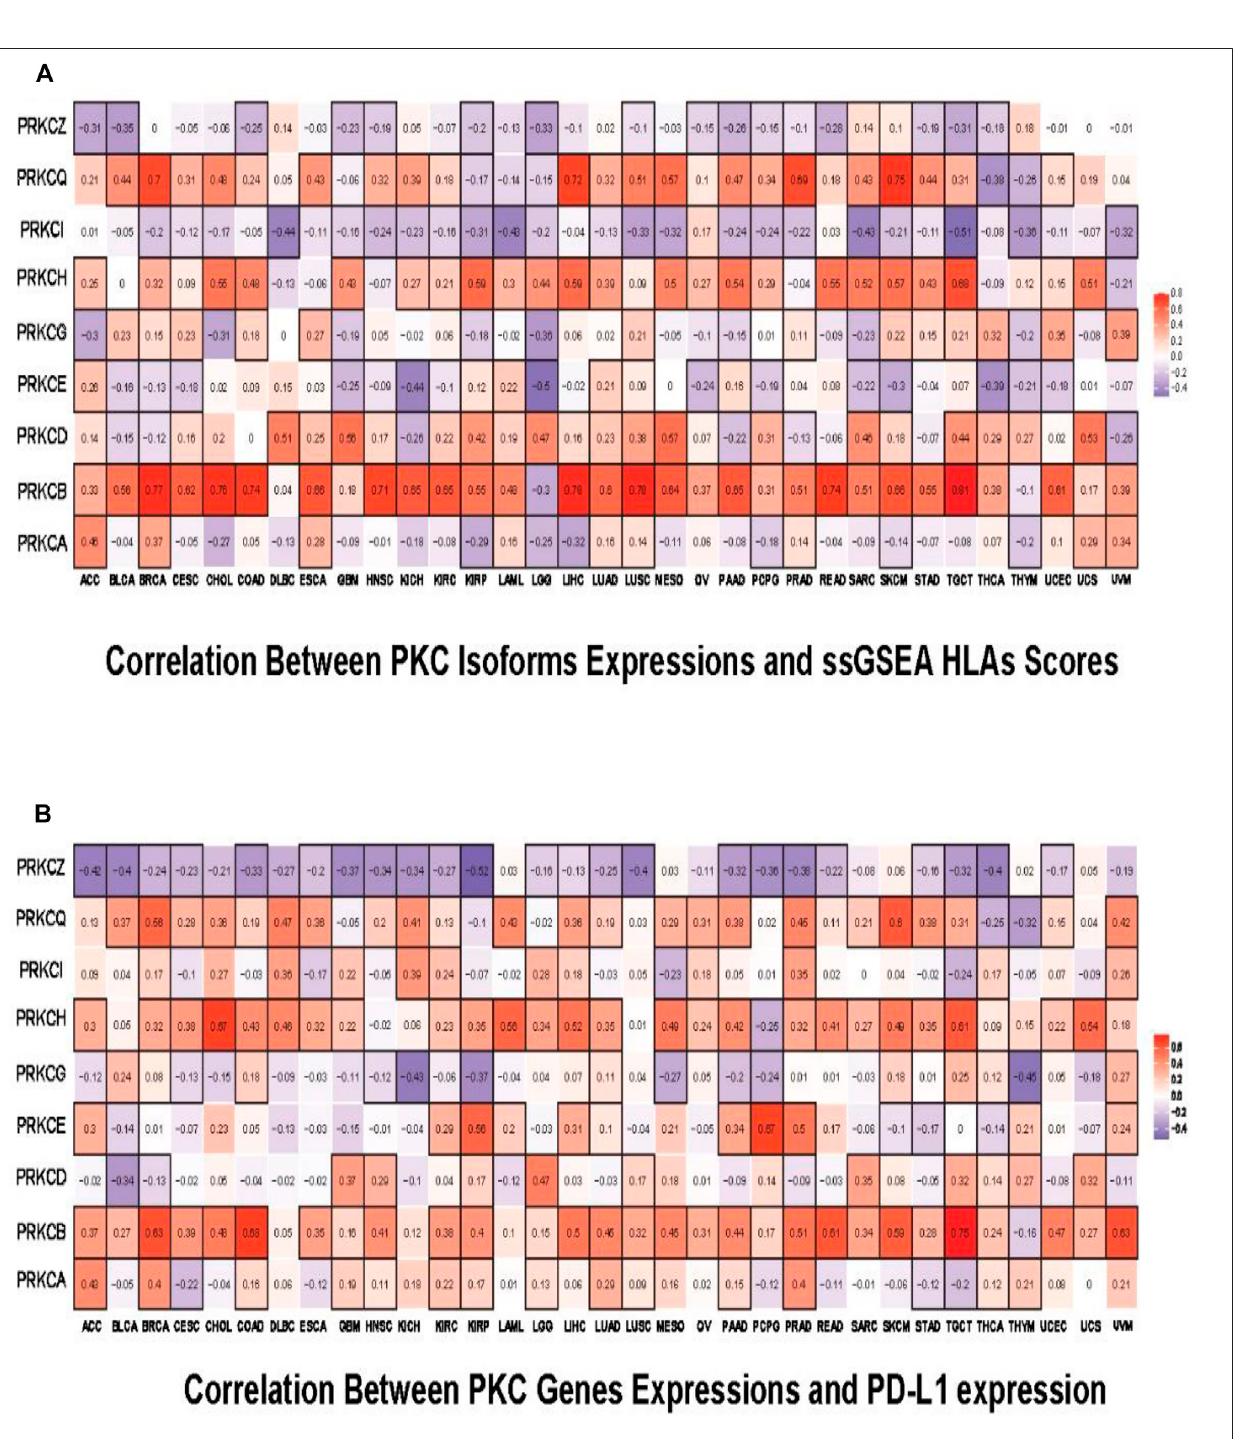
Frontiers in Cell and Developmental Biology |